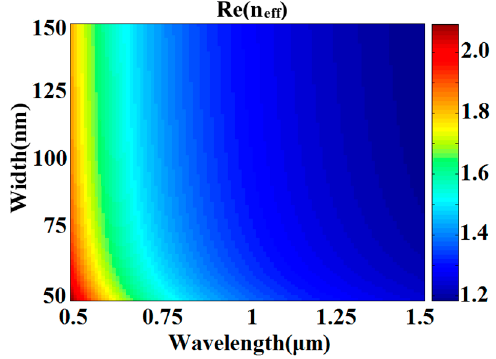
Figure 2. Real part of the effective refractive index n eff versus the incident wavelength λ and the width w in MIM waveguide.